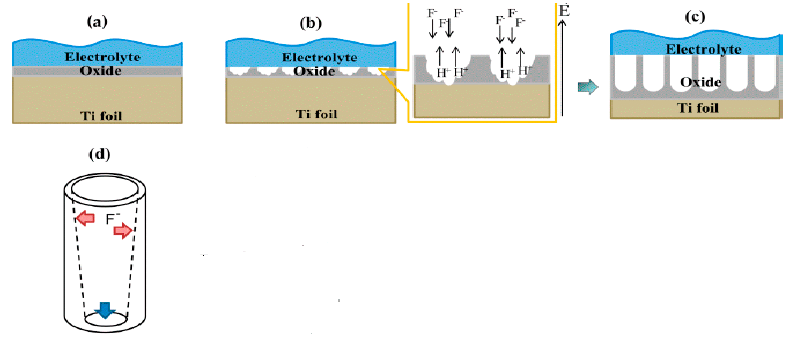
Figure 12. Schematic showing the formation of titania nanotube (TNT) arrays: ( a ) an initial development of a compact oxide layer on the surface of Ti, ( b ) small pits formation due to the etching of oxide by F − ions, ( c ) local growth of nanopores into well-aligned TNT arrays, and ( d ) the shape and wall thickness of a nanotube. Reproduced with permission from [223]. Copyright MDPI, 2019.